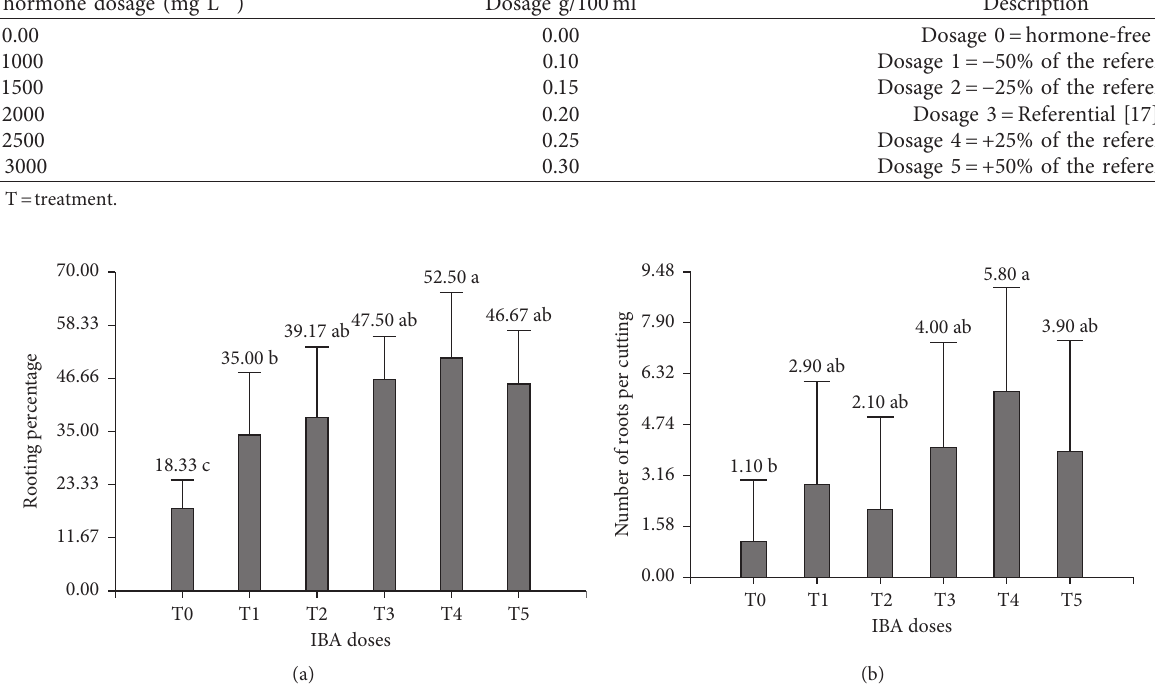
Figure 1: (a) Average percent rooting of cuttings. (b) The number of roots per